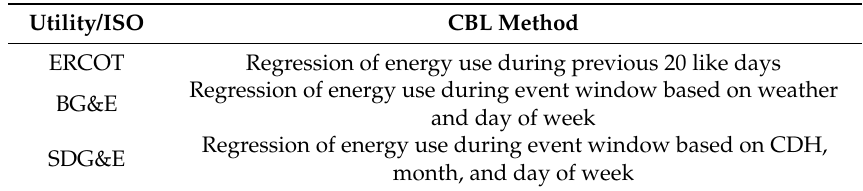
Table 3. Details of the regression method uses by certain utility companies and ISOs.